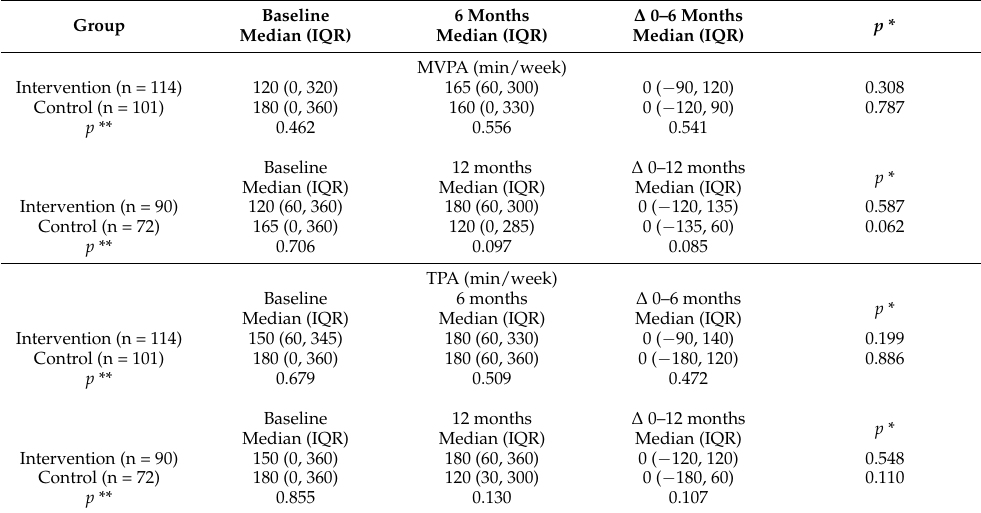
Table 2. Change in MVPA and total PA (min/week) at 6- and 12-month follow-ups, according to the study